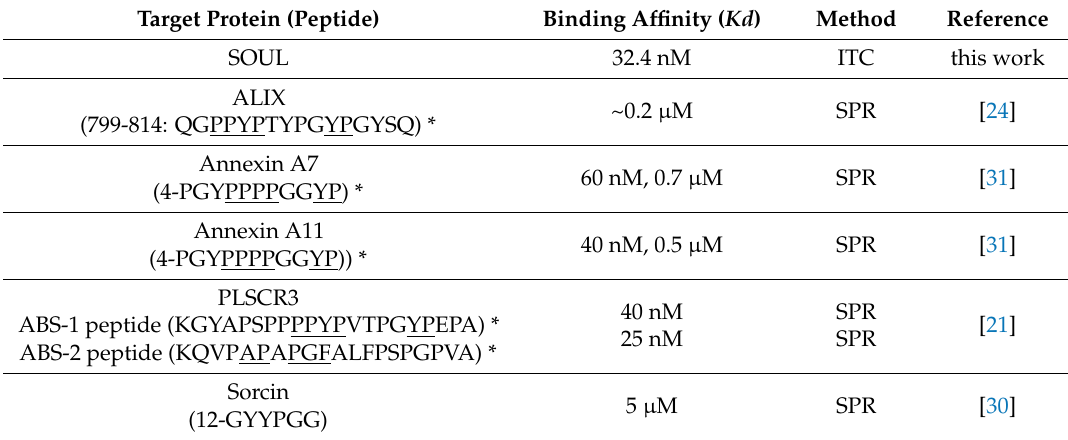
Table 2. Binding affinity of the target protein or peptide with Ca 2+ /ALG-2. Target Protein (Peptide) Binding Affinity ( Kd